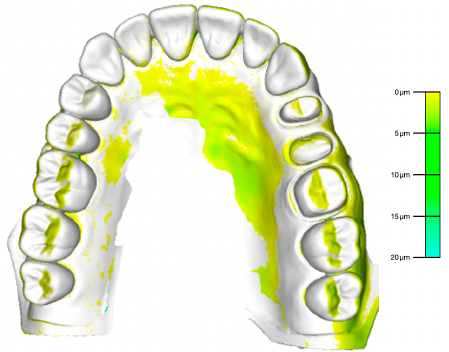
Figure 2. Visualization of the superimposed 3D-printed model with the reference by means of color mapping (Final Surface ® version 2019.0, GFaI e.V., Berlin, Germany).